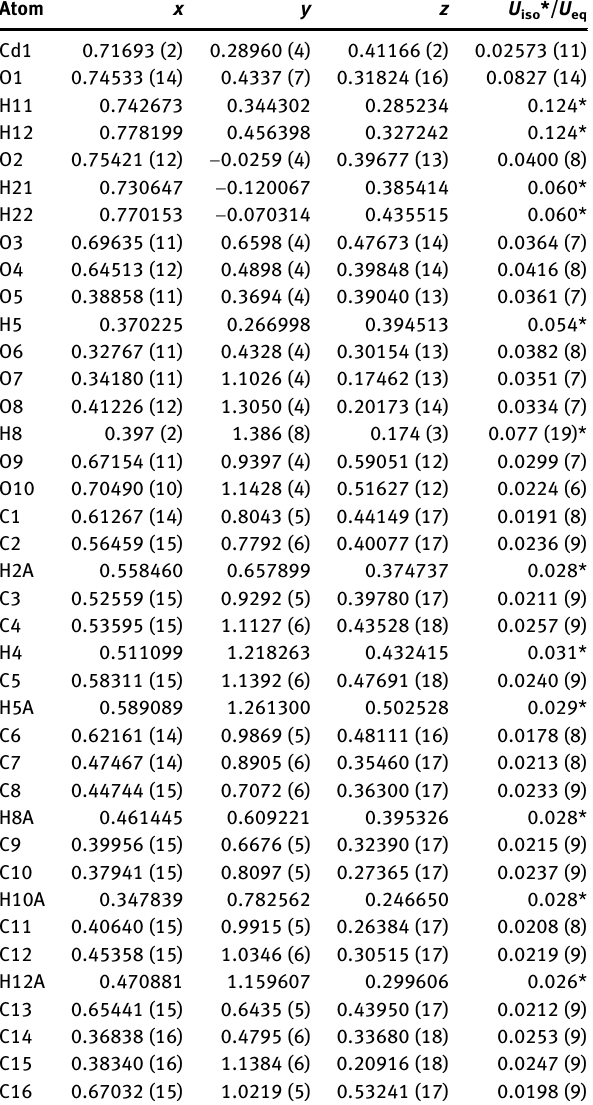
Table  : Fractional atomic coordinates and isotropic or equivalent isotropic displacement parameters (Å 